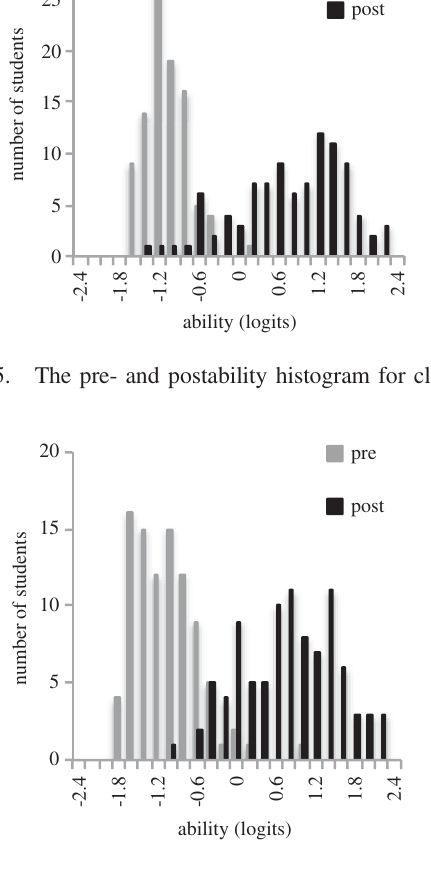
FIG. 16. The pre- and postability histogram for class 2.